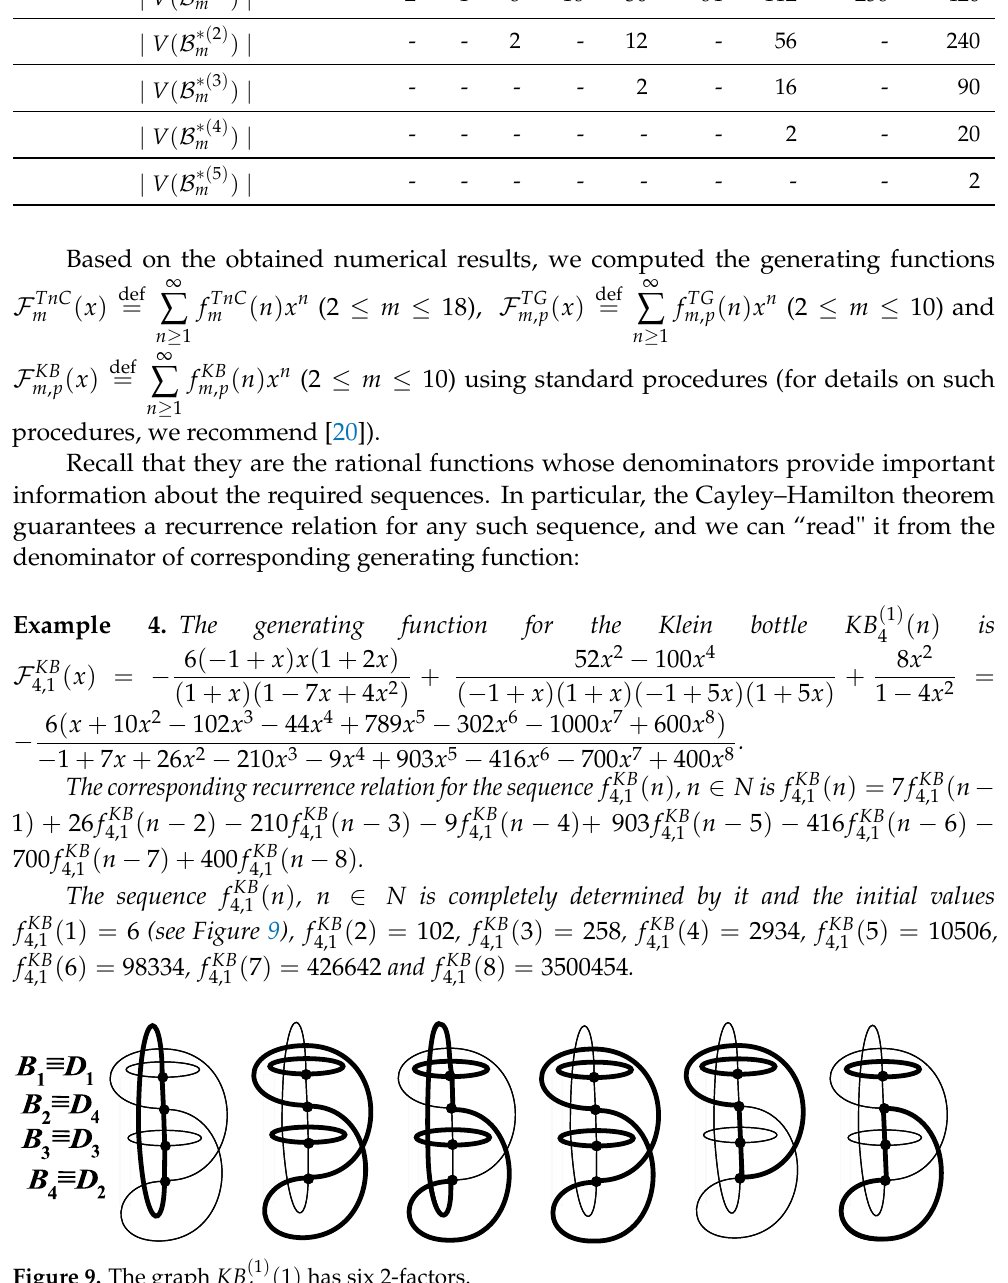
Figure 9. The graph KB The generating functions F TnC